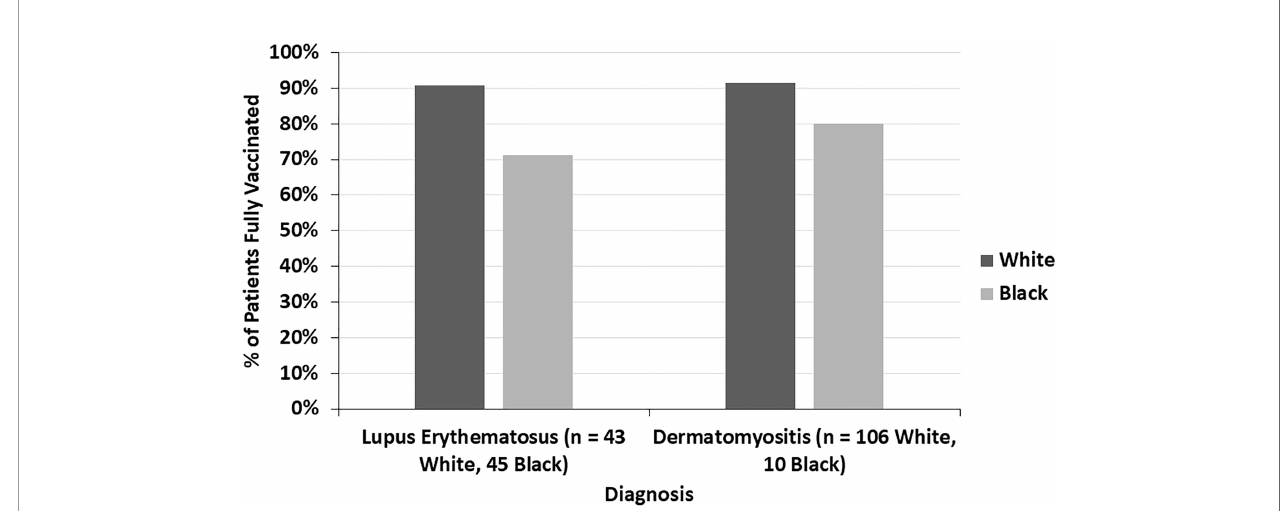
FIGURE 5 | The proportion of fully vaccinated lupus erythematosus and dermatomyositis patients is seen here by racial background (white and Black). In both diseases, a higher proportion of white patients were fully vaccinated compared to Black patients.